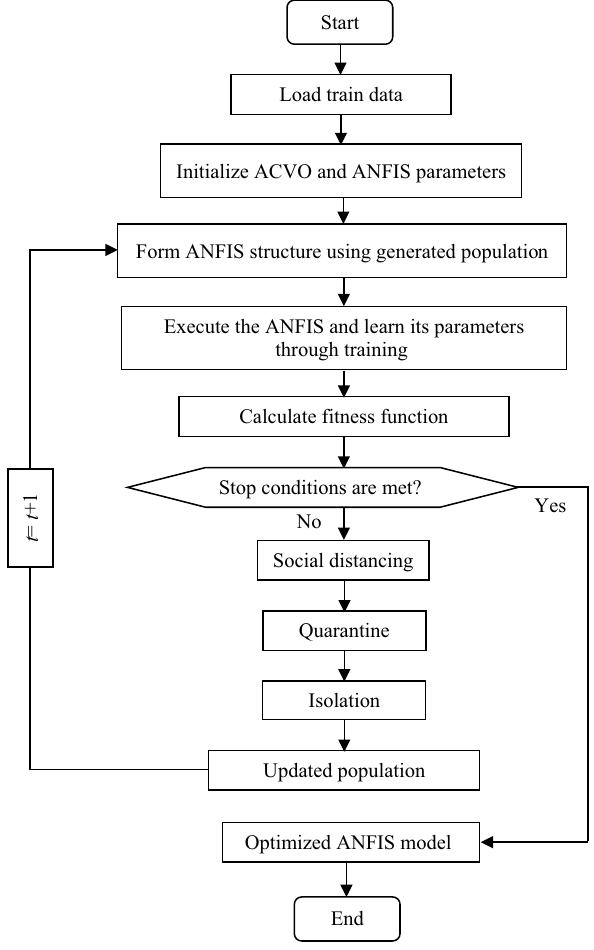
Fig. 5 Flowchart of the proposed ACVO-ANFIS